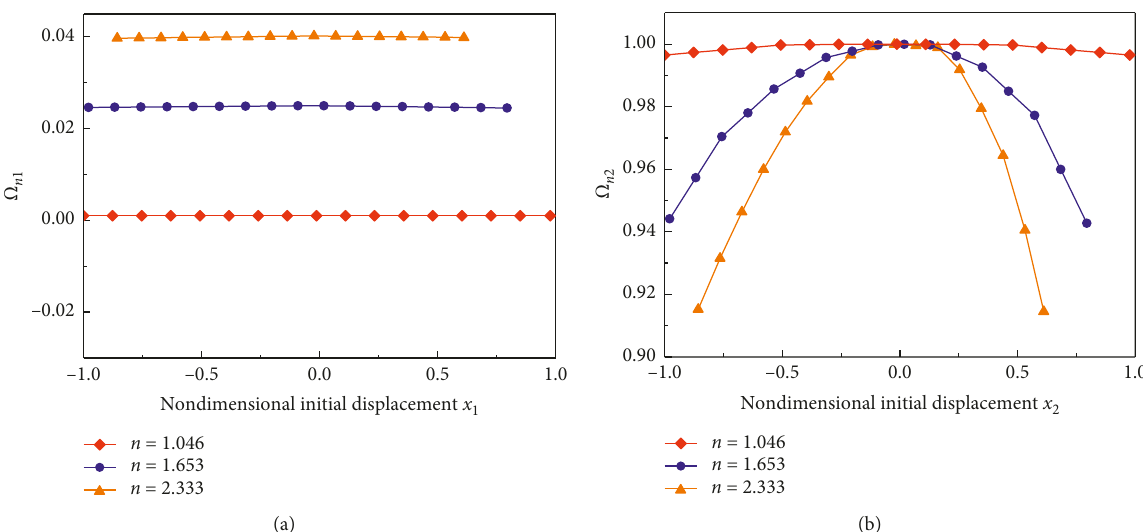
2 : (a) first-order natural frequency; (b) second-